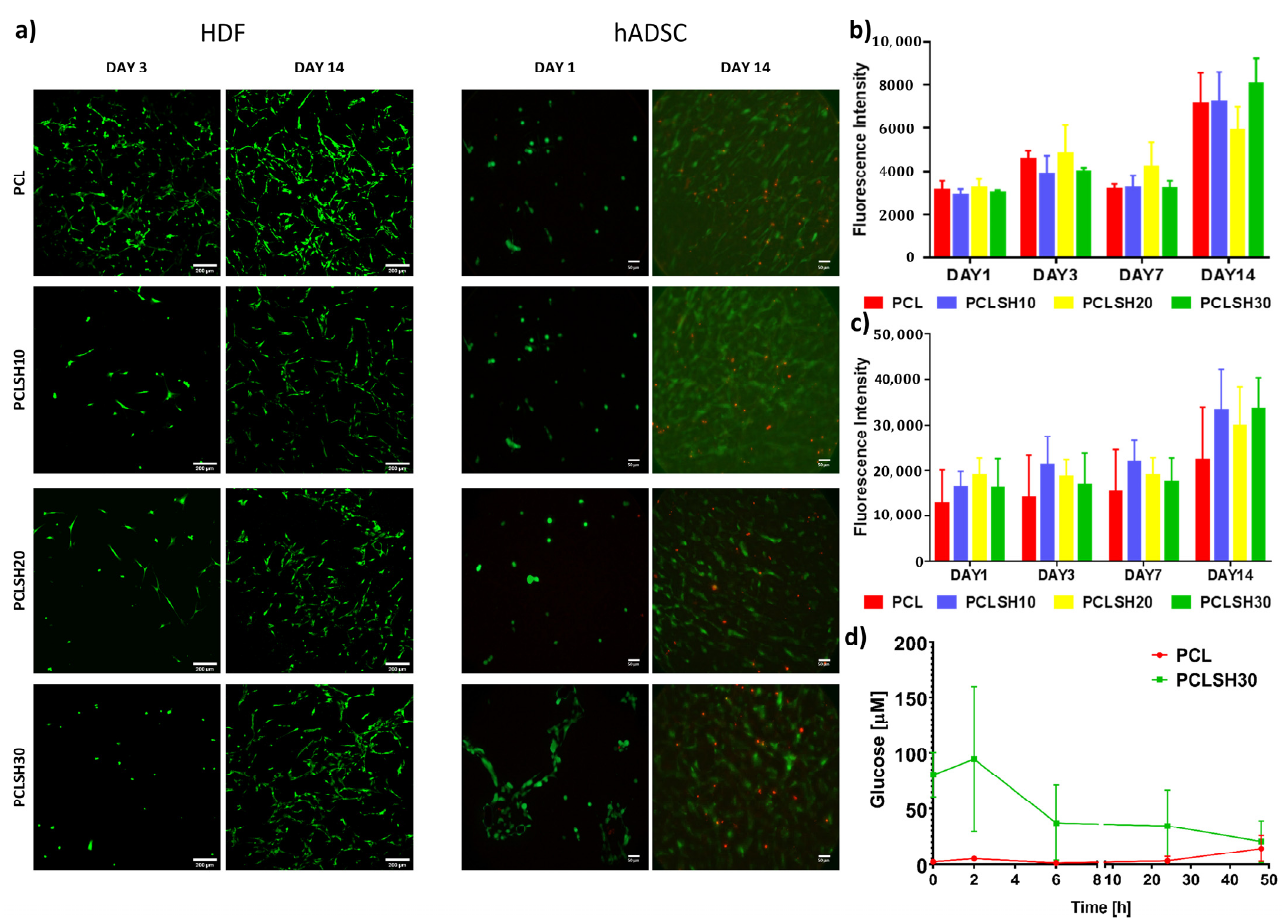
Figure 8. Cell metabolic activity and viability of HDFs and hADSCs on the electrospun meshes. ( a ) HDF viability at days 3 and 14 (green = live, red = dead) (scale = 200 µ m) and hADSC viability at day 1 and 14 (scale = 50 µ m). Metabolic activity of ( b ) HDFs and ( c ) hADSCs at day 1, 3, 7, and 14. ( d ) Glucose content of PCL and PCLSH30 meshes up to 48